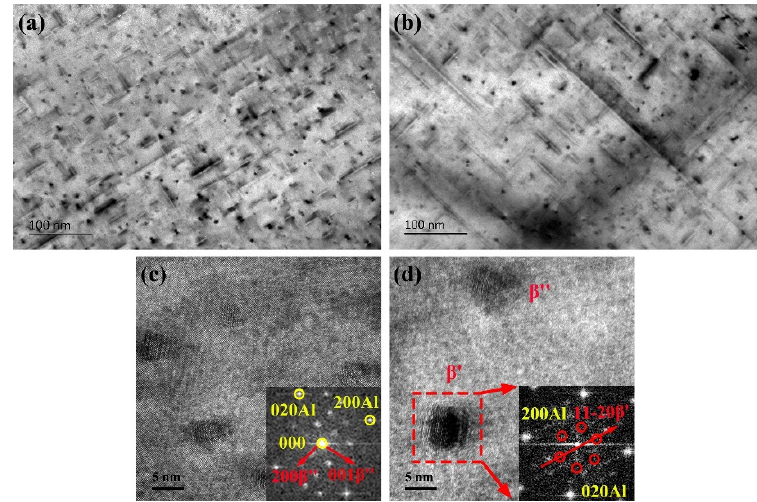
Figure 4. TEM bright-field images of ( a ) NA10 min-AA and ( b ) NA1440 min-AA. HRTEM images and FFTs of the β″ and β′ of ( c ) NA10 min-AA and ( d ) NA1440 min-AA; the images were taken with the electron beam along the <001>Al orientation. Table 1. The relative data of precipitates in NA10 min and NA1440 min.